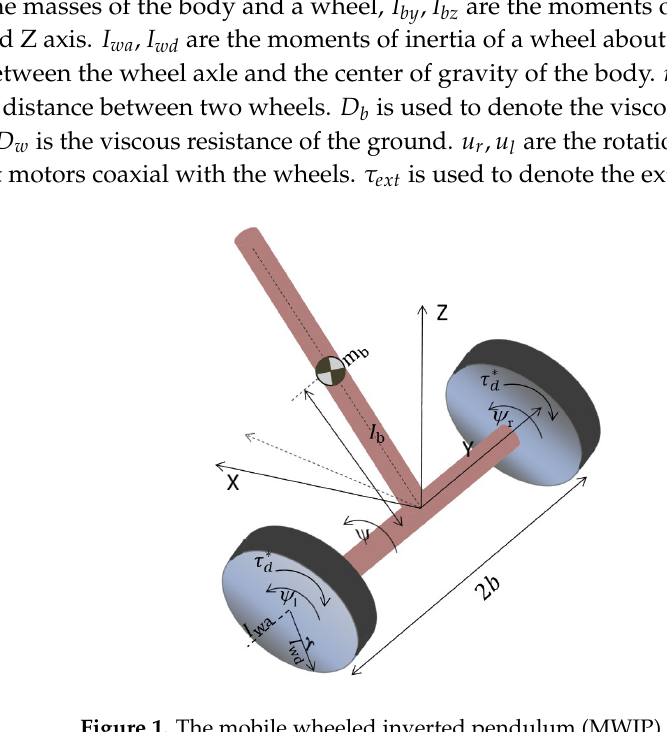
Figure 1. The mobile wheeled inverted pendulum (MWIP)